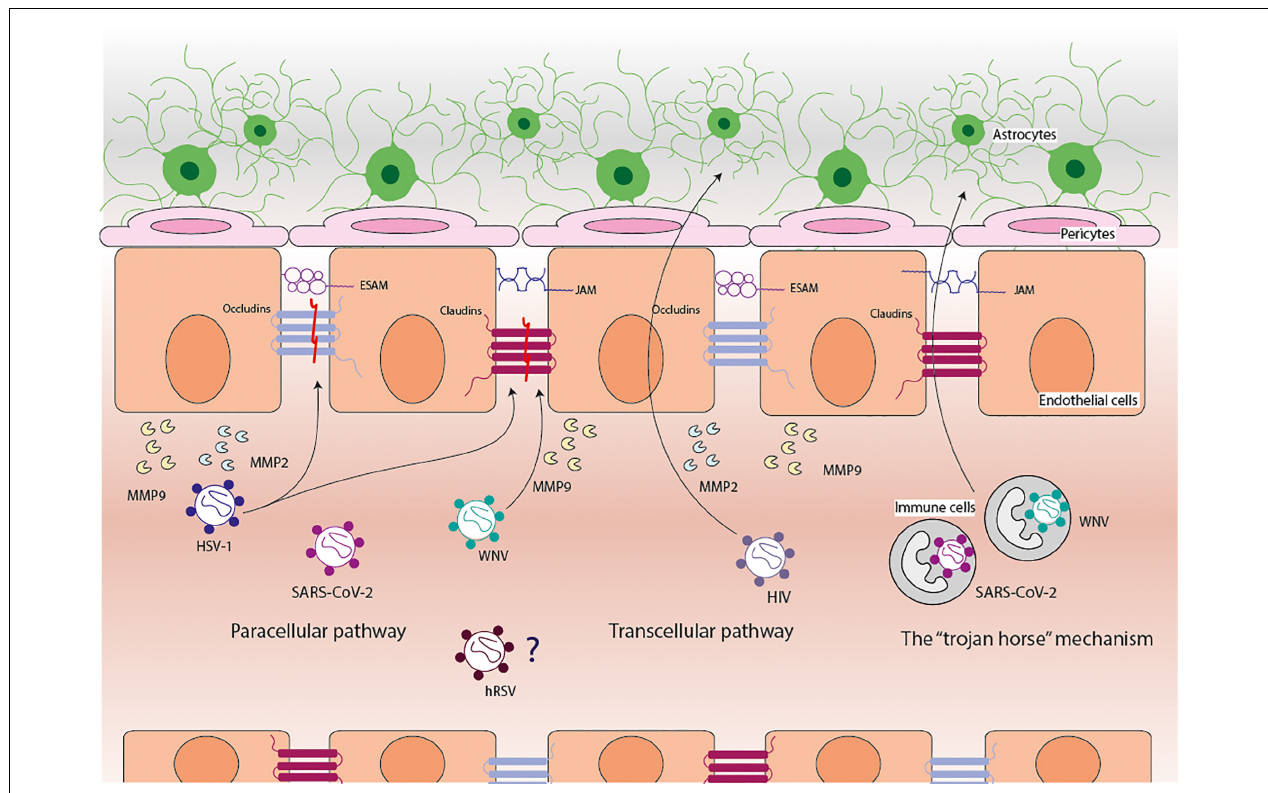
FIGURE 1 | Pathways used by viruses to cross the blood-brain barrier. The blood-brain barrier (BBB) is composed of endothelial cells, pericytes, and astrocytes cells. The viruses use three principal pathways to cross the BBB: paracellular, transcellular, and the “trojan horse” mechanism. West Nile virus (WNV) can reach the central nervous system via the paracellular pathway and the “trojan horse” mechanism, disrupting claudins and promoting the secretion of matrix metalloproteinases (MMPs) 9. Herpes simplex virus (HSV-1) can reach the central nervous system via the paracellular pathway, disrupting claudins and occludins and promoting the secretion of MMP2 and MMP9. Human immunodeficiency virus (HIV) can reach the central nervous system via the paracellular and transcellular pathways and promote the secretion of MMP2 and MMP9. SARS-CoV-2 can reach the central nervous system via the paracellular pathway and the “trojan horse” mechanism; however, it has not been elucidated how and what it promotes. Human respiratory syncytial virus (hRSV) can reach the central nervous system through the disruption of the BBB, but how and what it causes this has not been elucidated